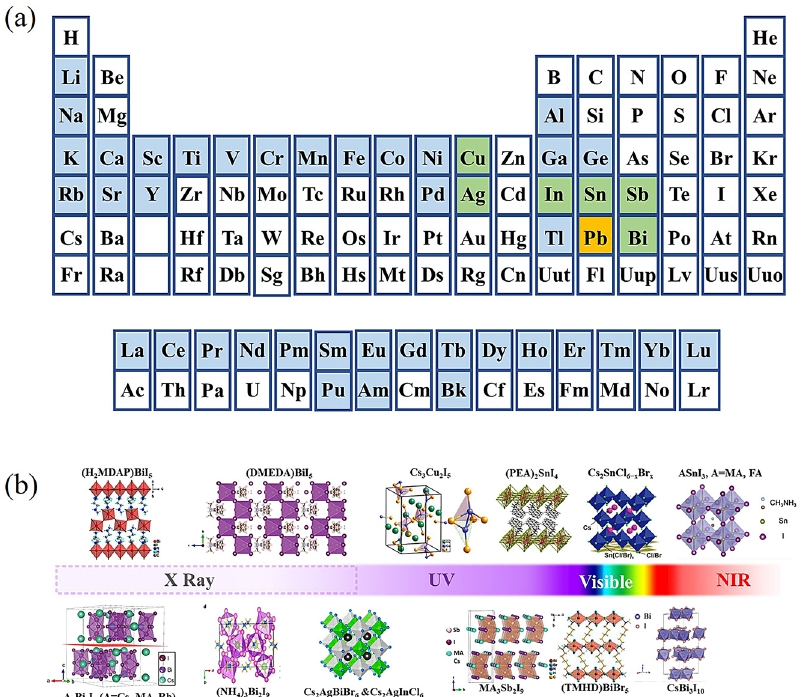
Figure 1: Elements for substituting lead, corresponding material structure and the photodetection